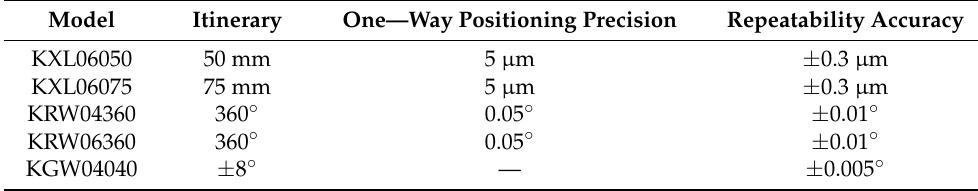
Table 3. Main parameters of the 6 DoF micromotion